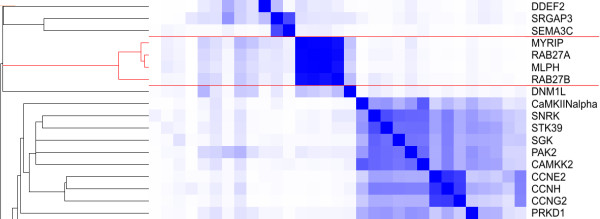
Fragment of the hierarchical clustering tree and heatmap based on the concept profiles for the genes differentially expressed following the agonistic stimulation of the androgen receptor. The tight cluster associated with melanosomes is highlighted.